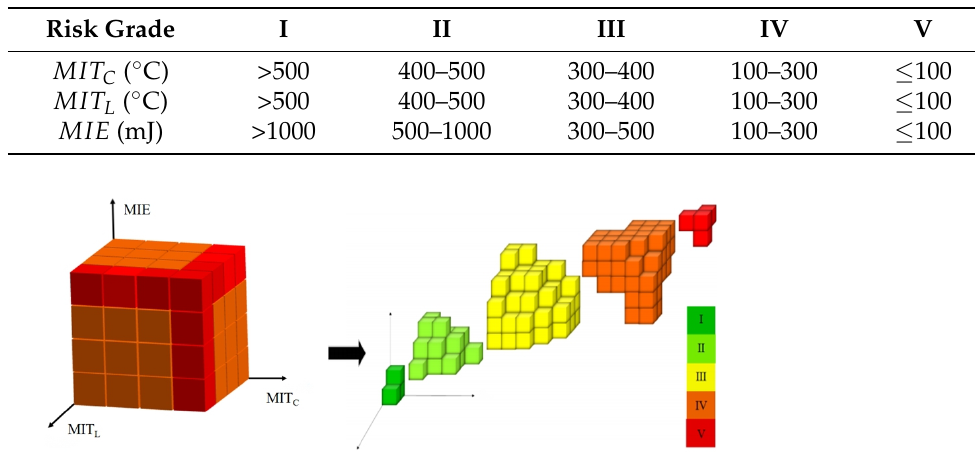
Figure 2. Three-dimensional risk matrix of dust explosion self-sensitivity classification. Table 2. Classification of dust explosion